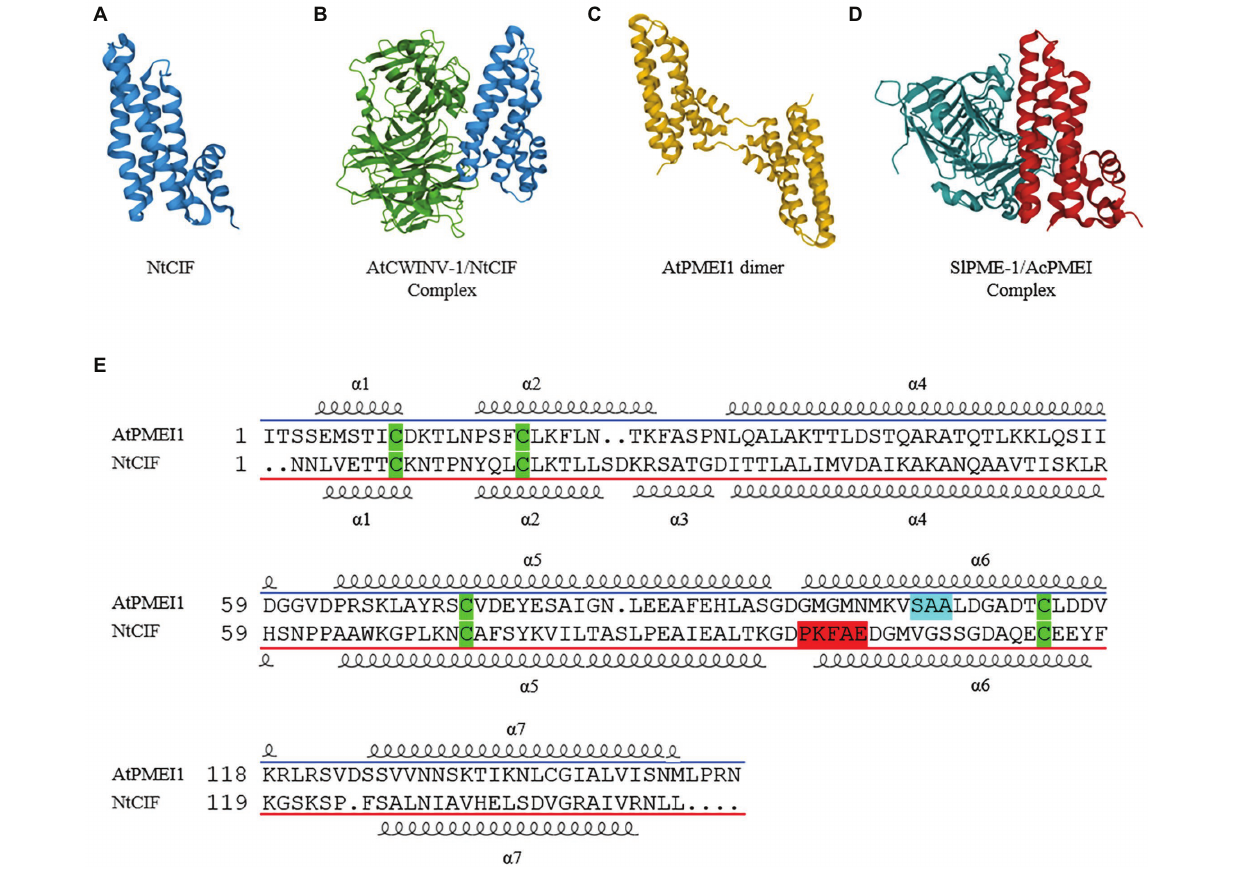
FIGURE 2 | Crystal structure of different INVI/PMEI isoforms alone or in complex with their enzymatic counterpart. (A) NtCIF (PDB ID; 1RJ1) and (B) NtCIF in complex with AtCWINV-1 (PDB ID; 2XQR). (C) AtPMEI1 dimer (PDB ID; IX8Z) and (D) AcPMEI in complex with SlPME-1 (PDB ID; 1Xg2). (E) Sequence Comparison of AtPMEI1 and NtCIF. The most conserved motifs are highlighted in light blue for PMEI and in red for INVI. The four cysteine conserved in both inhibitors are highlighted in green. The α symbols followed by numbers indicates the different